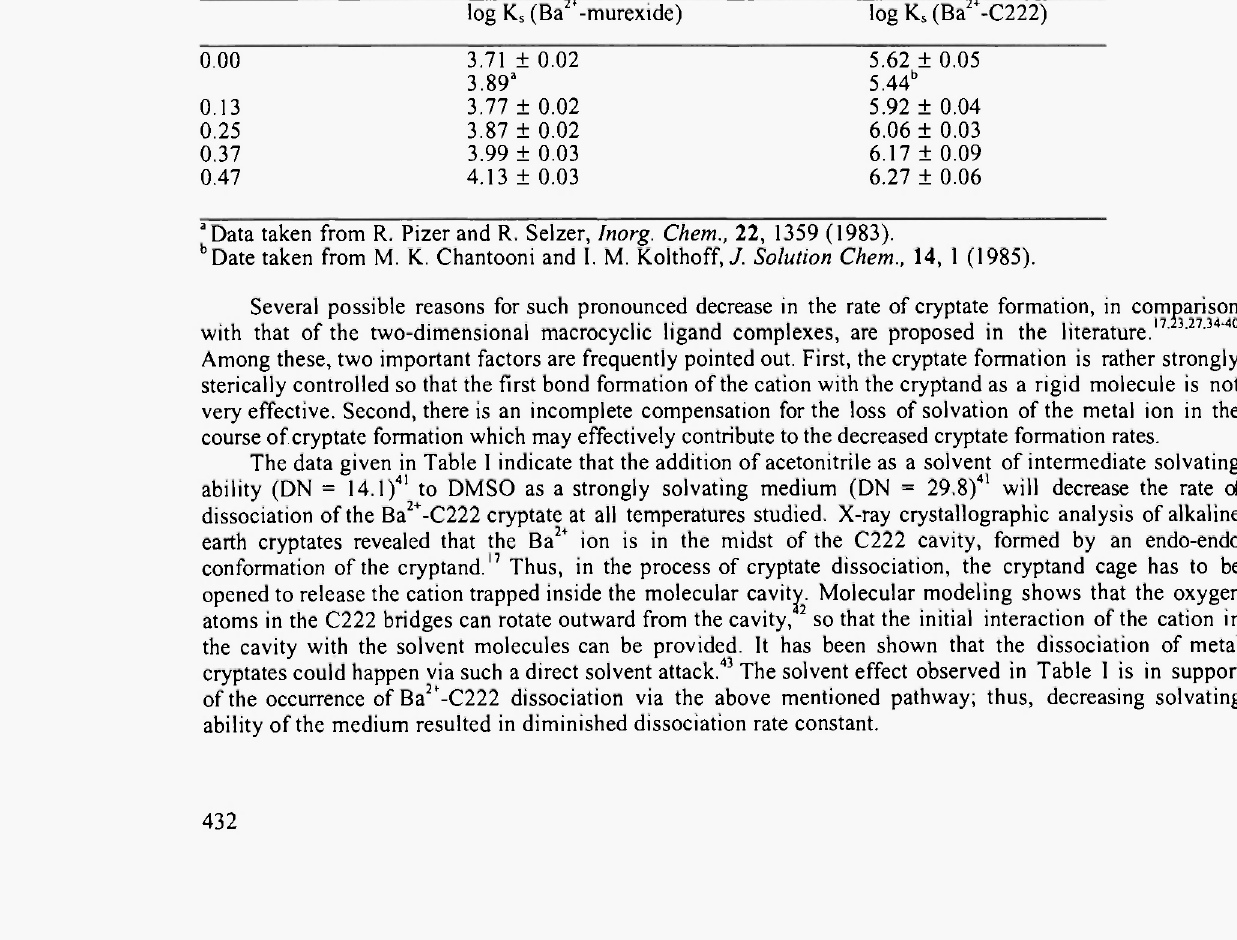
Fig. 2. Arrhenius plots for the dissociation of Ba 2 -C222 cryptate in different DMSO-AN mixtures. X A n: 1, 0.0; 2, 0.13; 3, 0.25; 4, 0.37; 5, 0.47. Table 11. Stability constants for Ba 2 ' complexes with murexide and C222 in different DMSO-AN mixtures at 298 Κ log K s (Ba J '-murexide) log K 5 (Ba'*-C222)